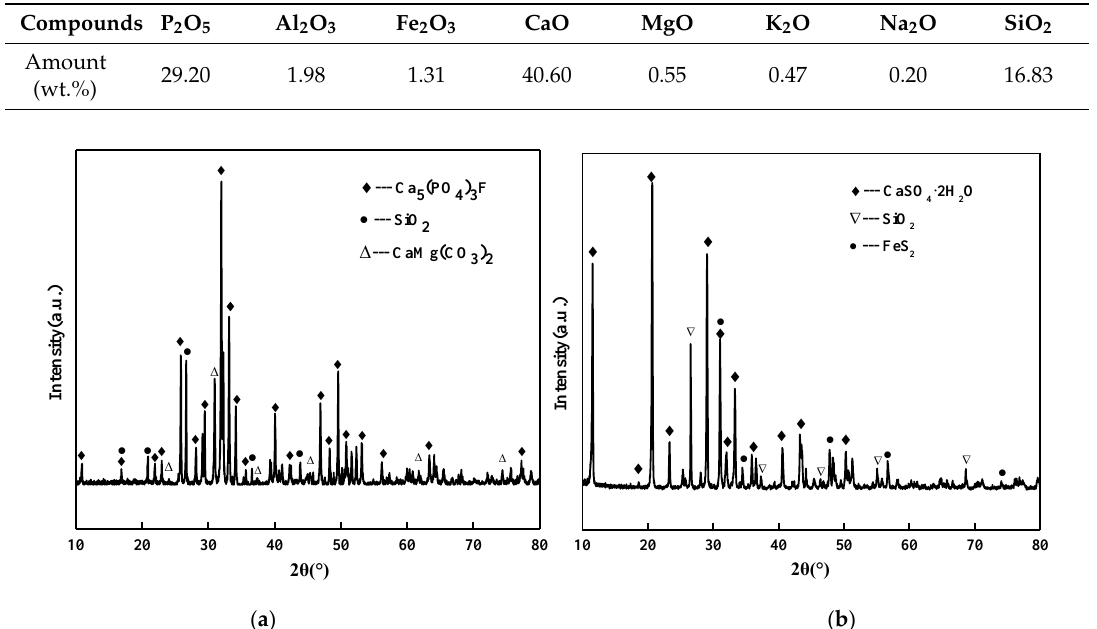
Table 1. Composition of phosphate rock. Table 2. composition of phosphogypsum.